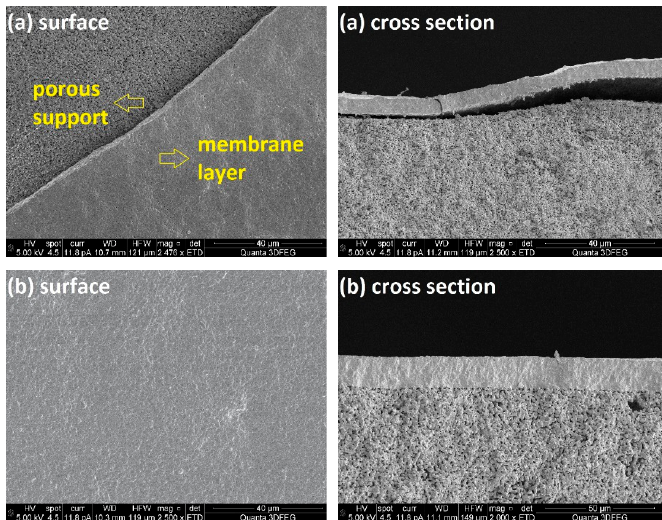
Figure 3. Scanning electron microscopy (SEM) images of CGO layers fabricated on ( a ) MgO and ( b ) MgO-CGO dual-phase support tubes.